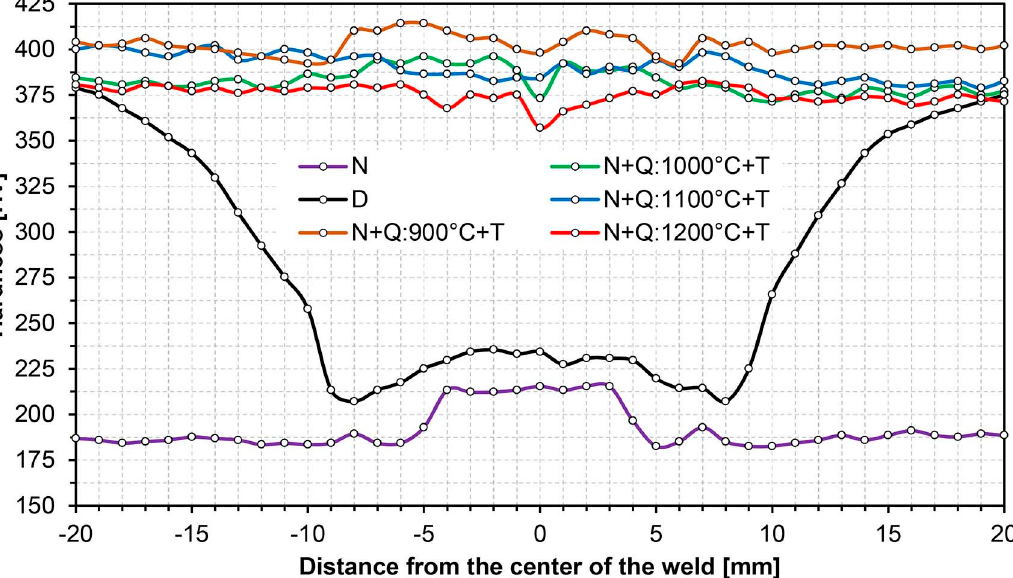
Figure 3. Hardness distributions of the welded joint of Hardox 450 along line A in Figure 1: D—delivery state (directly after welding), N—normalised state, Q—quenched state, T—tempering.